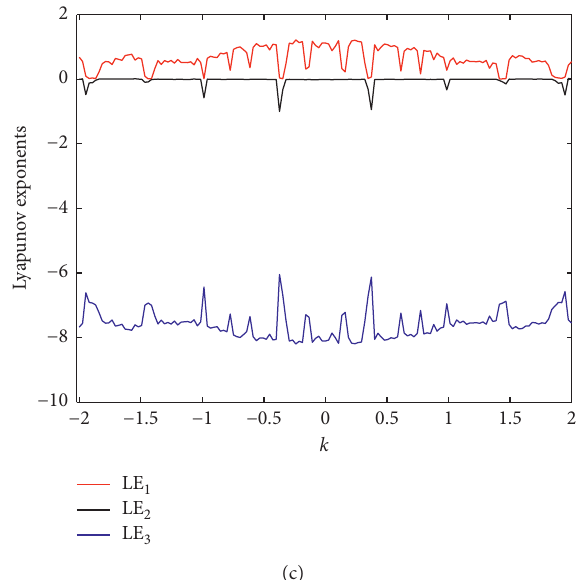
Figure 6: (a, b) Bifurcation diagram versus k ; (c) finite time Lyapunov exponent spectrum versus k .